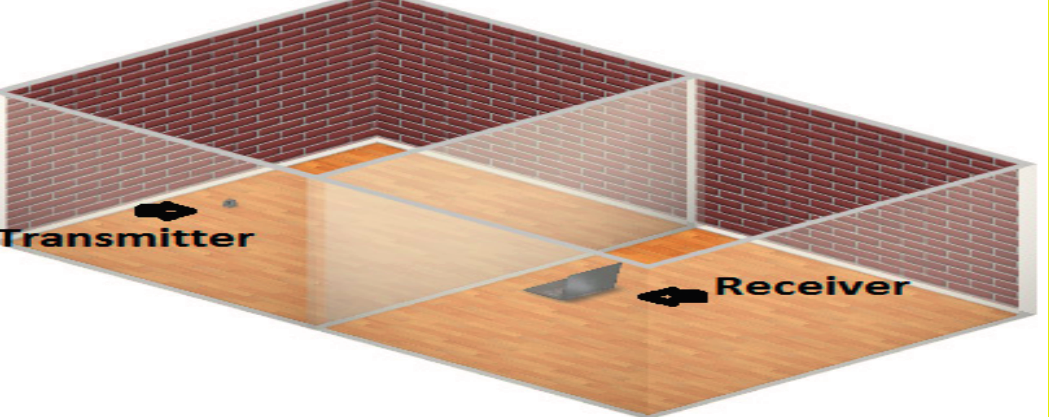
Figure 14. Experimental setup to evaluate the attenuation caused by different building materials in the smart building